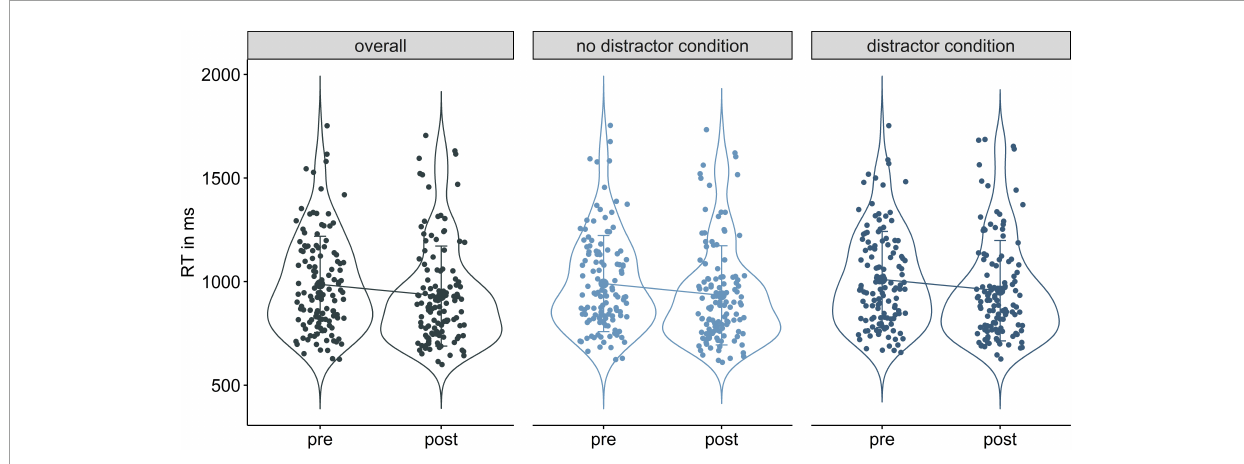
FIGURE5 Violin plots of reaction time decreases from pre to post in the overall (left) , no distractor condition (middle) , and distractor condition (right)